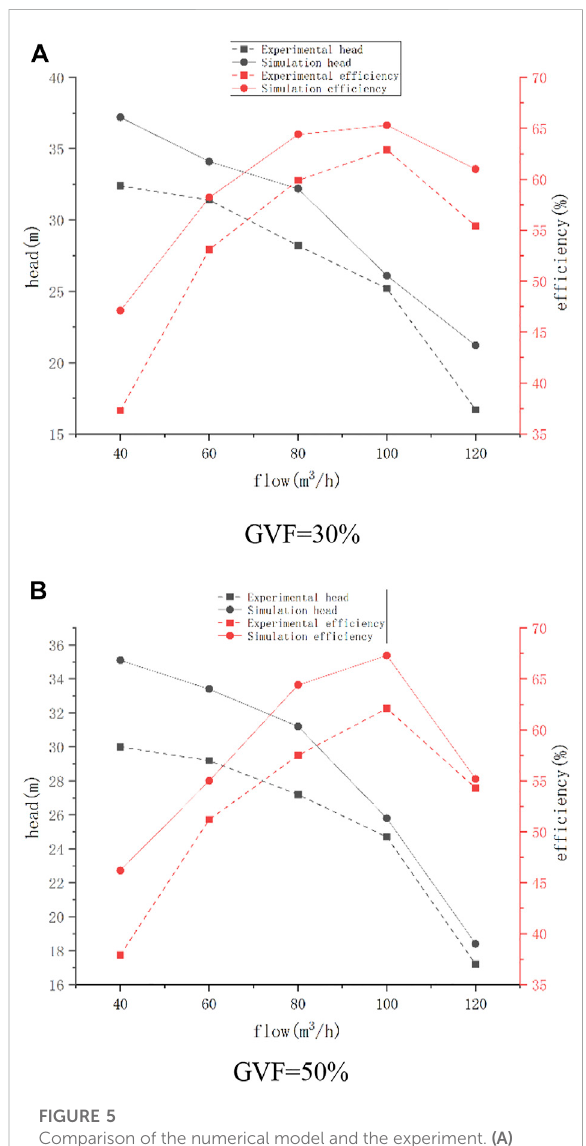
FIGURE 5 Comparison of the numerical model and the experiment. (A) GVF = 30%. (B) GVF =